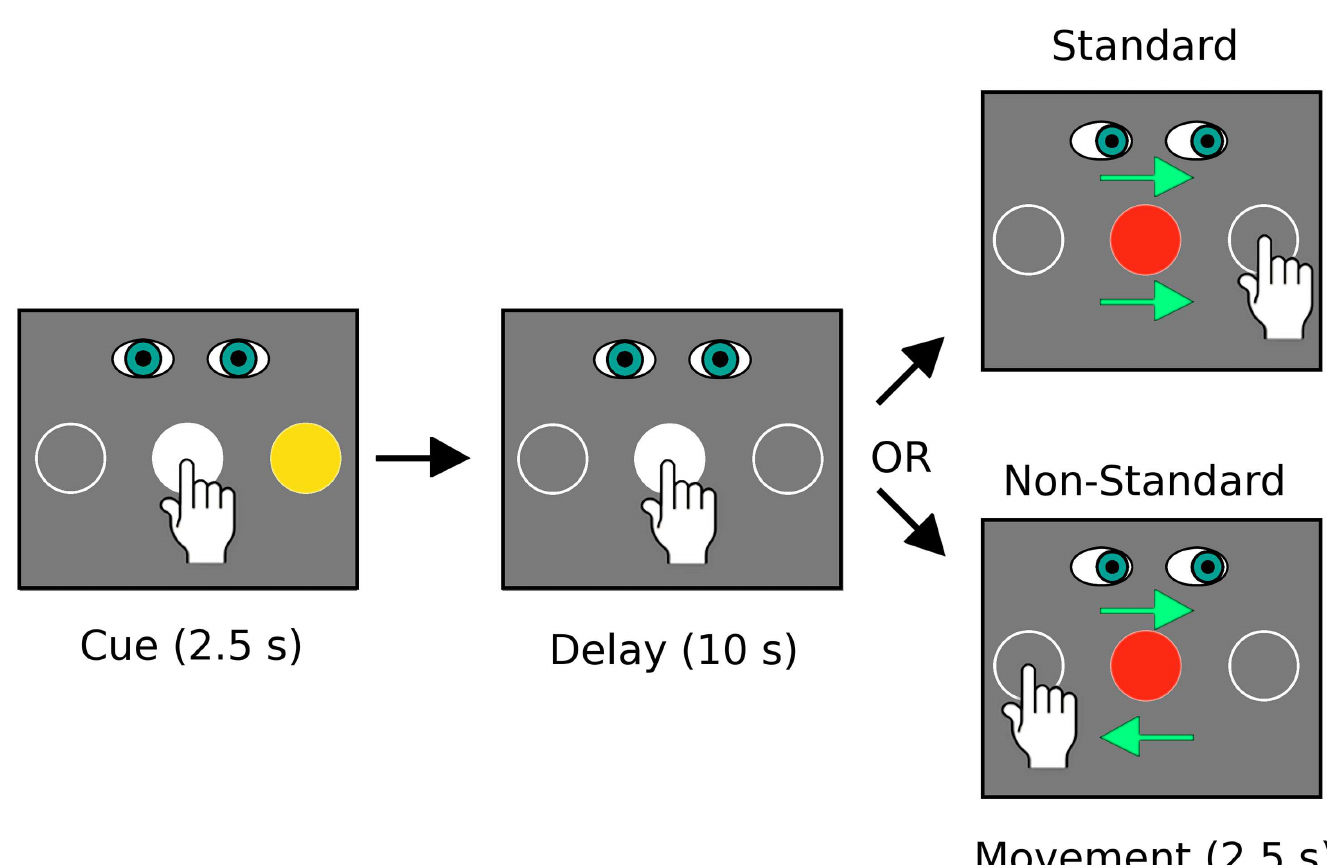
Fig 1. The standard and non-standard visuomotor mapping conditions. In both conditions participants were required to fixate on and touch the central target during the cue and delay periods. The central target turned from white to red to indicate the go signal for movement initiation. At this signal participants saccaded to and slid their finger on the touch screen to the cued target location in the Standard condition. In the Non-Standard condition participants also saccaded to the cued target location but slid their hand to the opposite target. Note that the conditions were the same for both Experiment 1 (fMRI) and Experiment 2 (behavioural) but in the second experiment the delay period was decreased from 10 seconds to a variable delay of 1.5 +/- 0.5 seconds.